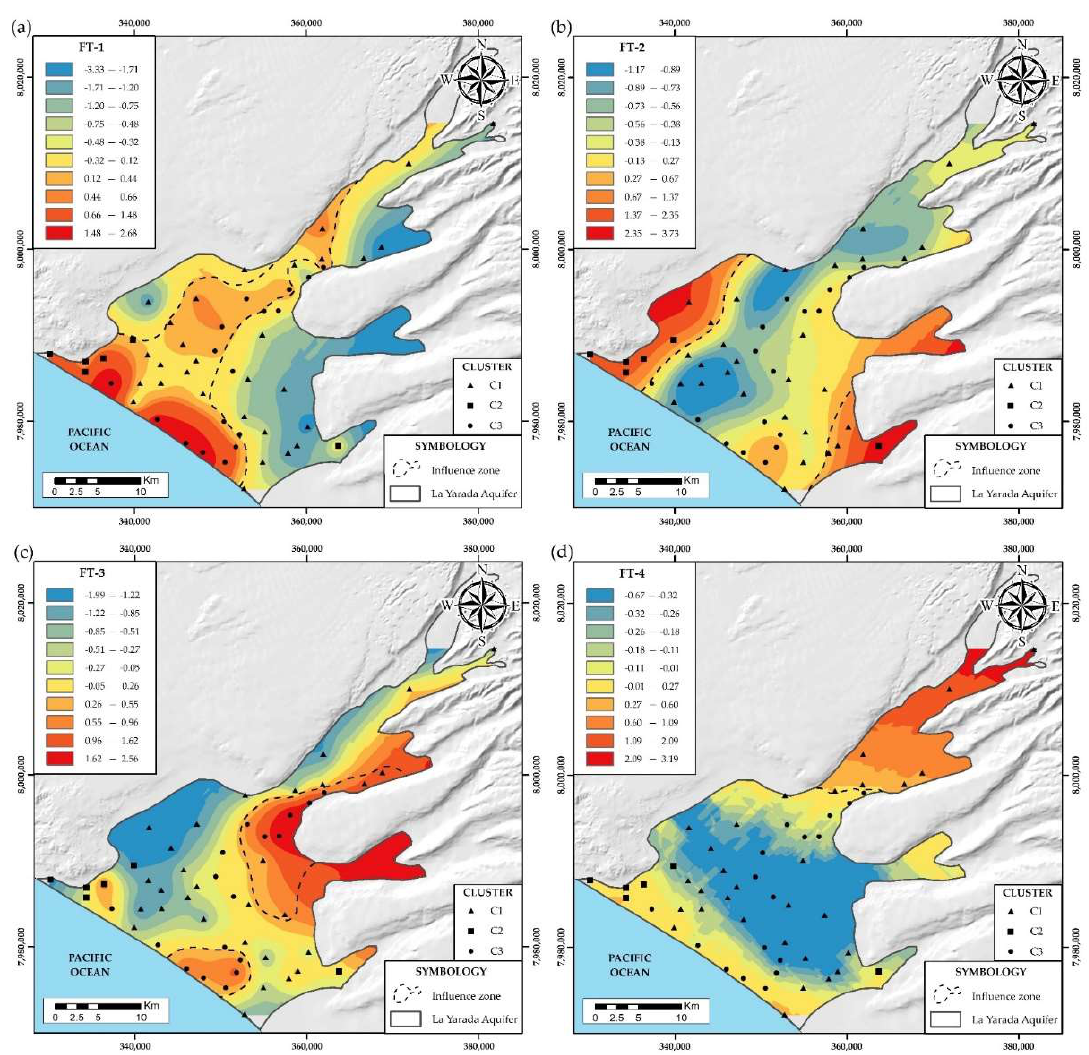
Figure 11. ( a ) Spatial distribution of factor FT-1. ( b ) Spatial distribution of factor FT-2. ( c ) Spatial distribution of factor FT-3. ( d ) Spatial distribution of factor